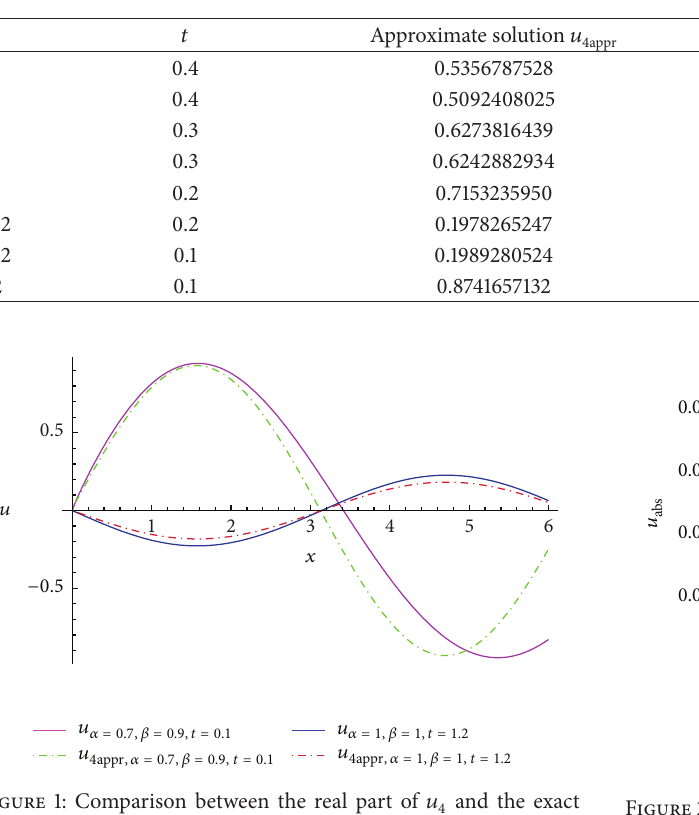
Table 2: Comparison between the real part of 𝑢 4 and 𝑢 when 𝛼 = 0.7, 𝛽 = 0.9 .